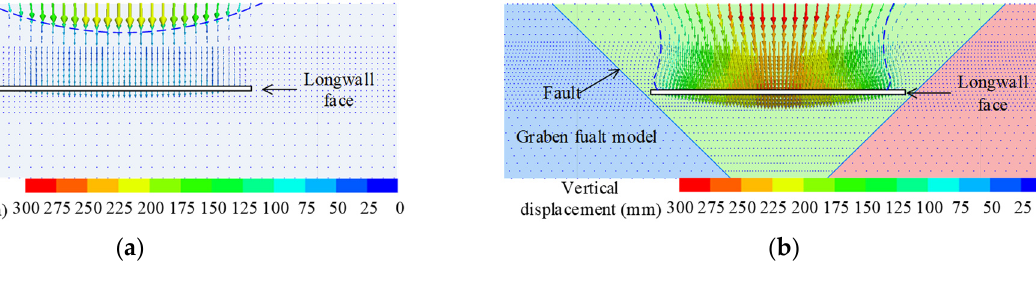
Figure 6. Vertical displacement distribution contour (cross-section of 30 m behind the longwall face). ( a ) Base model; ( b ) Graben fault model.